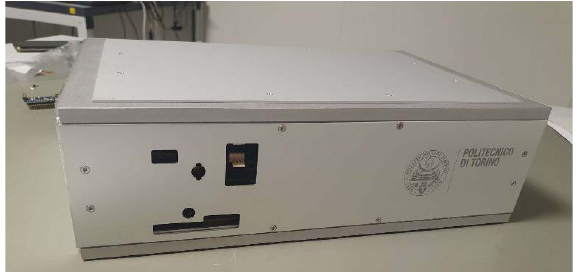
Figure 2. Focus on the external interface .